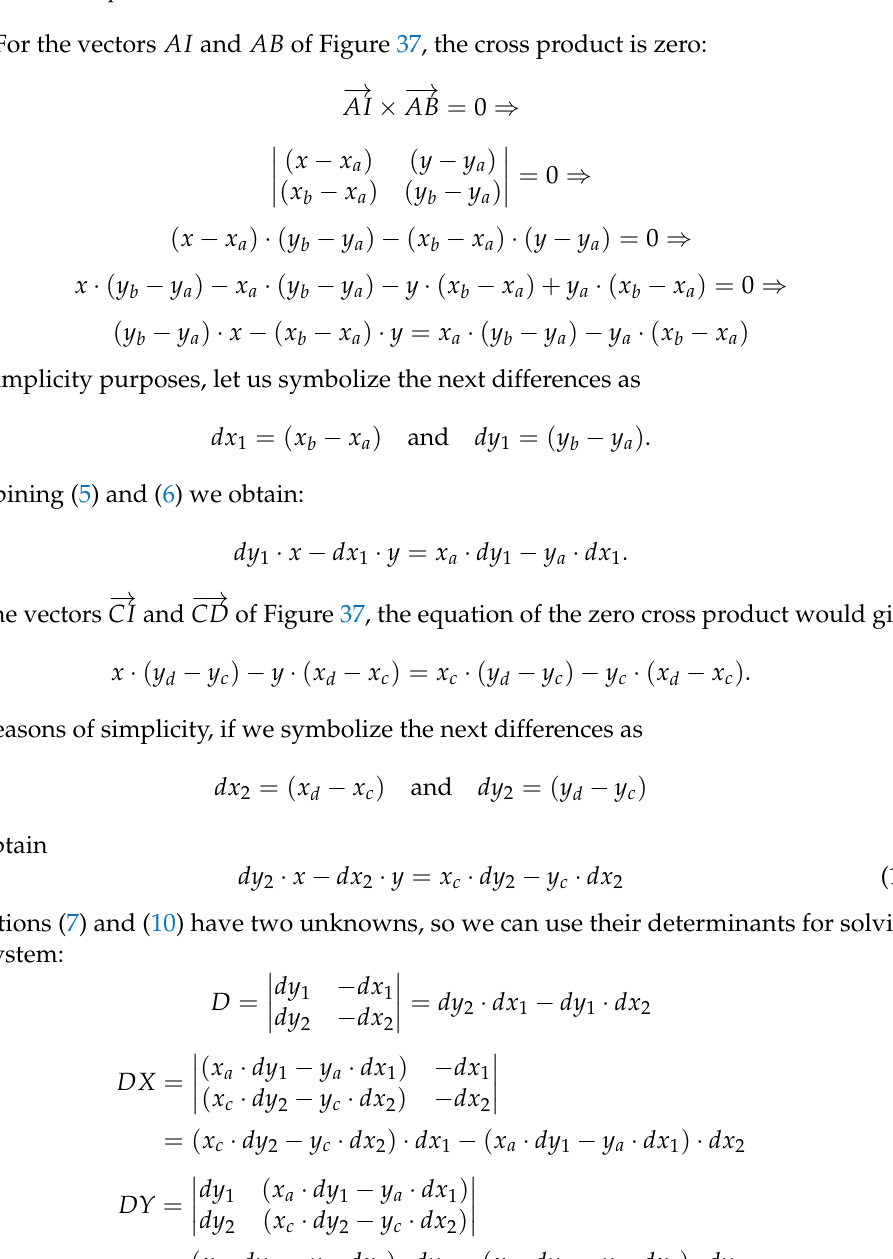
Figure 37. Cross product between the vectors AI and AB as well as between CI and CD is